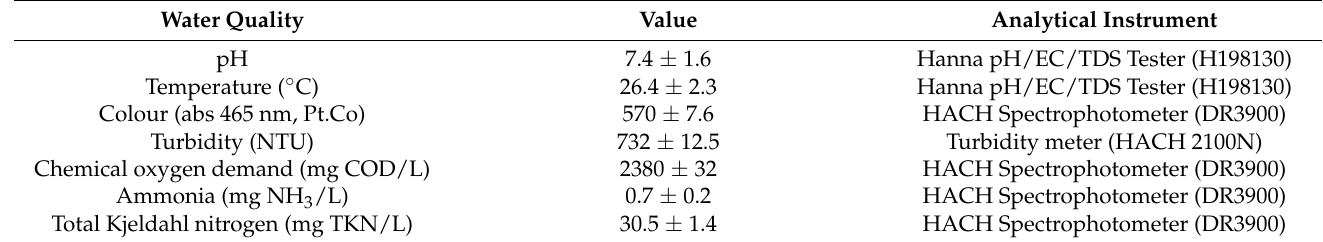
Table 5. The characterization of wastewater and activated sludge